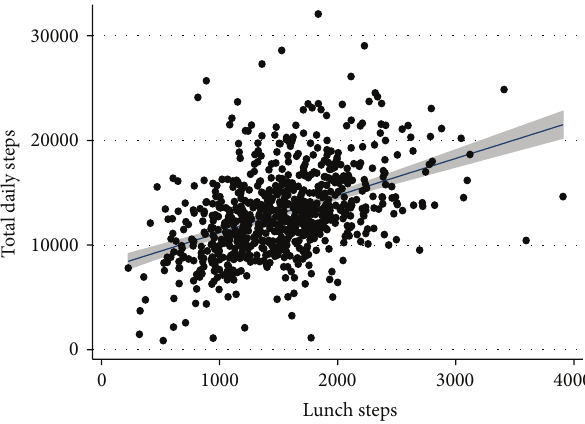
Figure 2: Scatterplot and line of best fit showing the linear relationship between lunch recess steps and total daily steps ( 𝑟 = 0.44 ; 𝑃 < 0.001